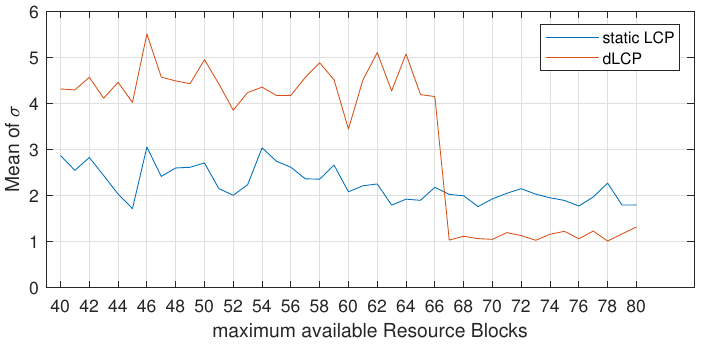
Figure 11. Jitter for TSN Packet Size of 900